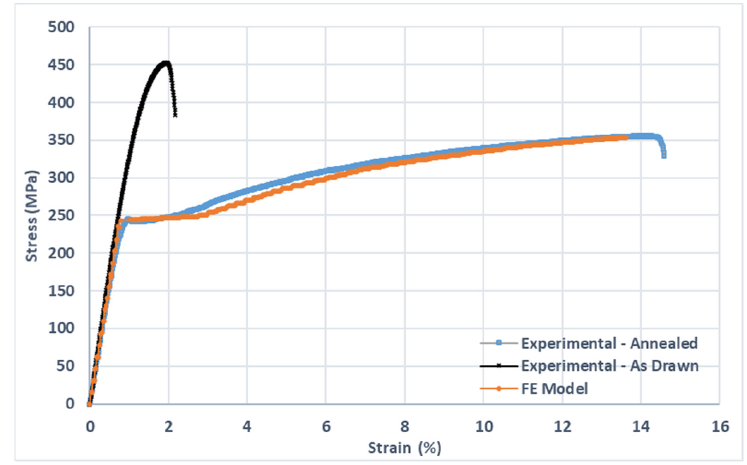
Figure 8. Average stress–strain curves from tensile testing of wire specimens, for both “As drawn” and “Annealed” conditions. The FE model results are also shown for comparison purposes. Table 1. Average mechanical properties for both as-drawn and annealed wire specimens (n = 3). Thermal